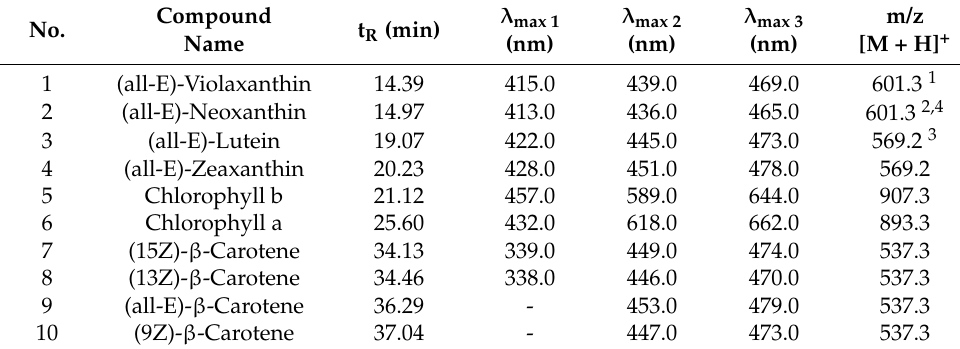
Table 1. Identified compounds in kale extracts with experimental parameters derived from external standard measurements.